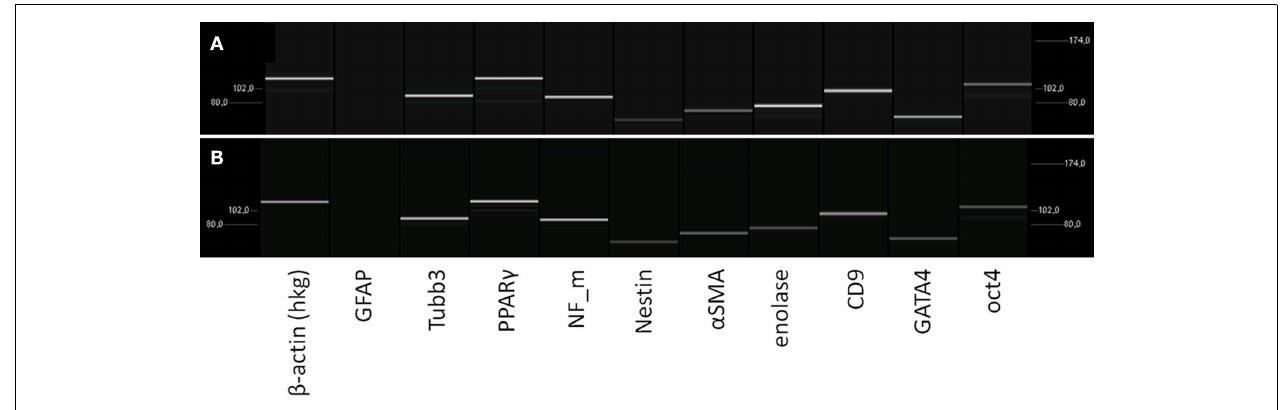
FIGURE 3 | Characterization of the mRNA-expression in rat pancreatic stem cells grown on cell culture plastic (A) and polyimide˚2 film (B). Cells were analyzed in regard to their transcriptome by utilizing RT-PCR.The subsequent capillary gel electrophoresis shows transcripts typical for all germ layers and stemness.